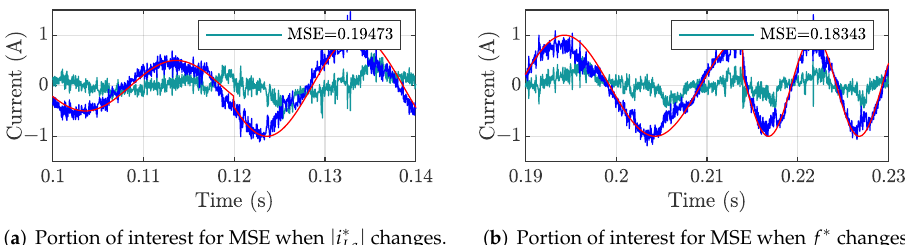
Figure 10. Experimental results for phase a in transient conditions.